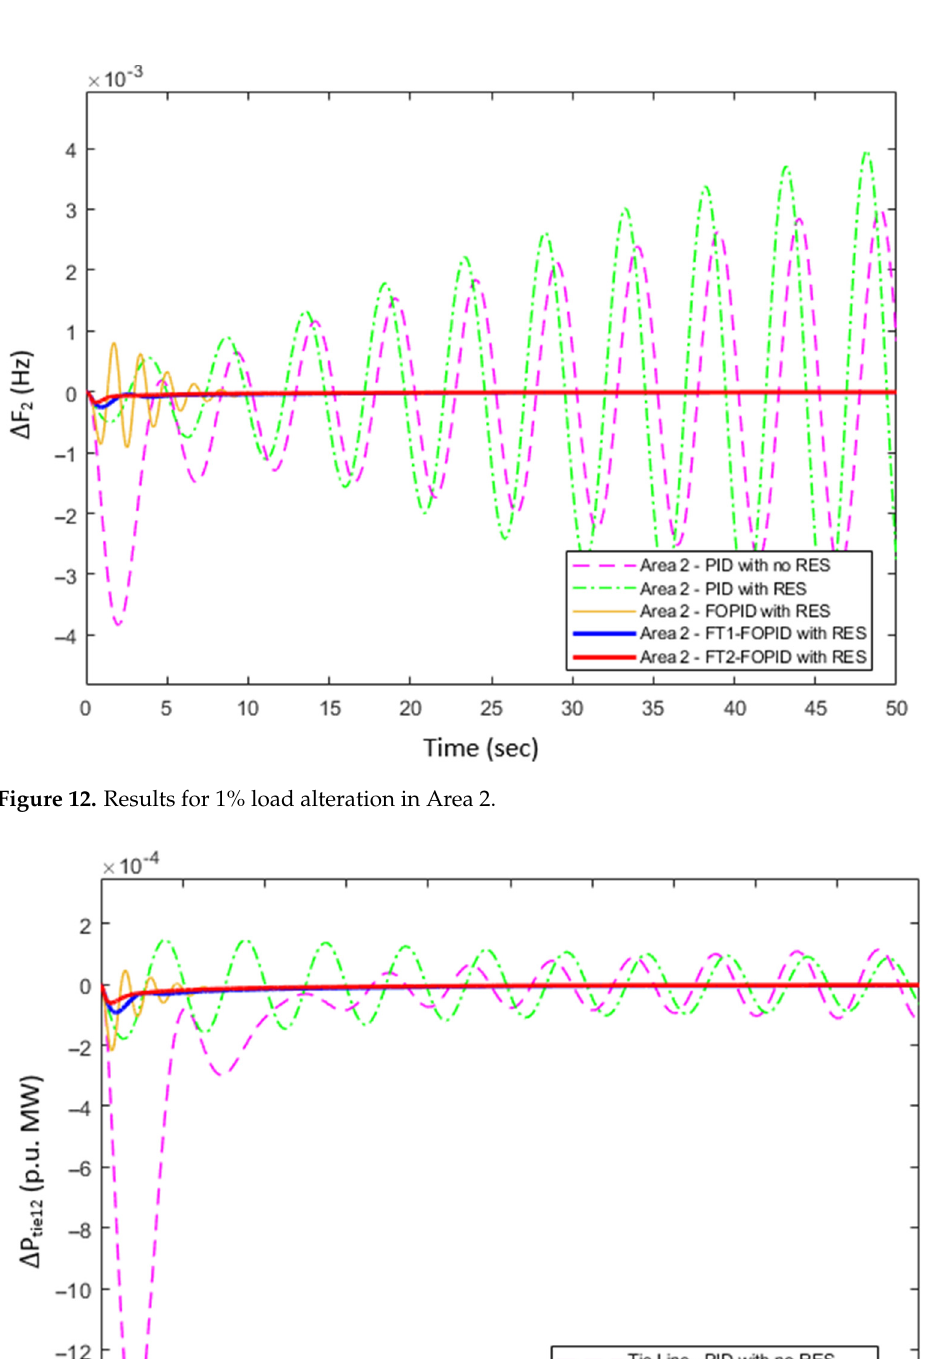
Figure 11. Results for 1% load alteration in Area 1.